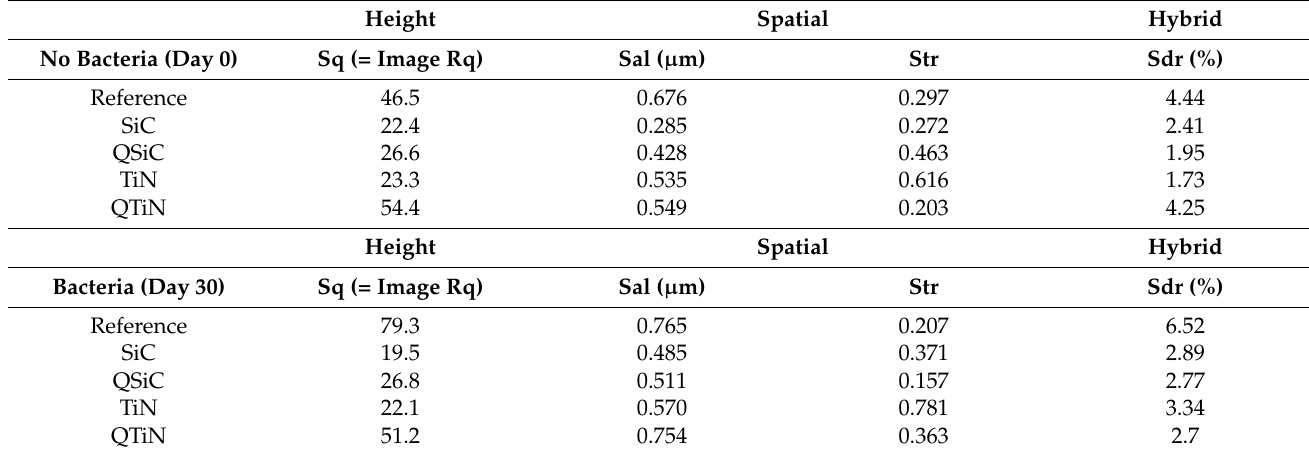
Table 1. The spatial parameters of AFM for non-coated (Reference) and coated (TiN, QTiN, SiC, and QSiC) disks initially (Day 0) and after 30 days in cultivation with